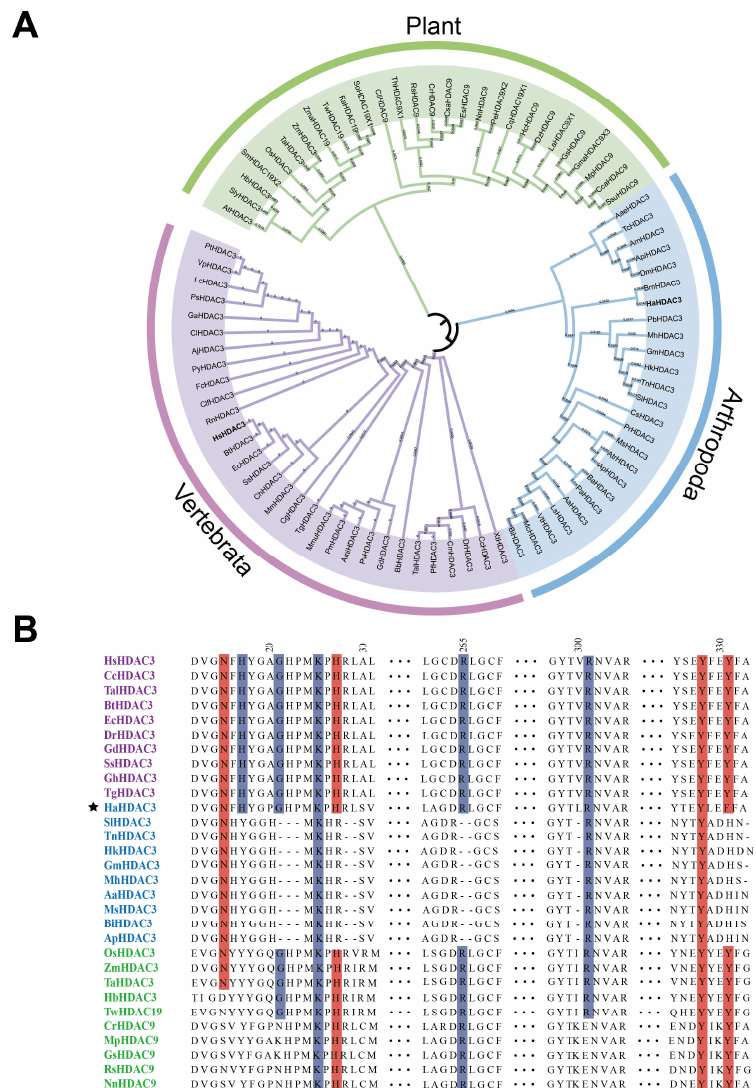
Figure 1. Phylogenetic analysis and sequence alignment of HDAC3 in various species. ( A ) HDAC3 protein sequences of various plants, arthropods, and vertebrates were aligned, and an NJ phylogenetic tree was constructed using MEGA-X. We used a bootstrap method with 1000 iterations to test the tree. ( B ) Ten sequences from each group (plants, arthropods, and vertebrates) were further analyzed. Residues that mediate interaction with Ins(1,4,5,6)P4 and SMRT-DAD are highlighted in blue and red, respectively. The star marks the H. armigera